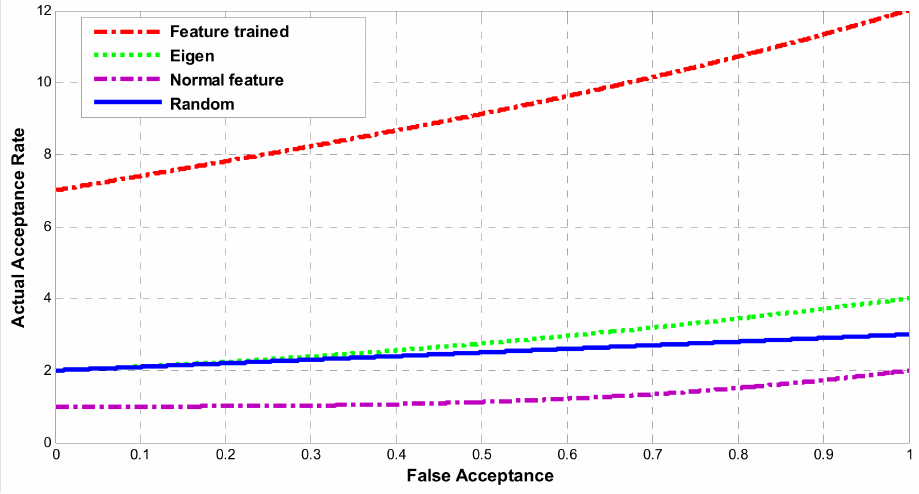
Figure 8. False acceptance rate (FAR).